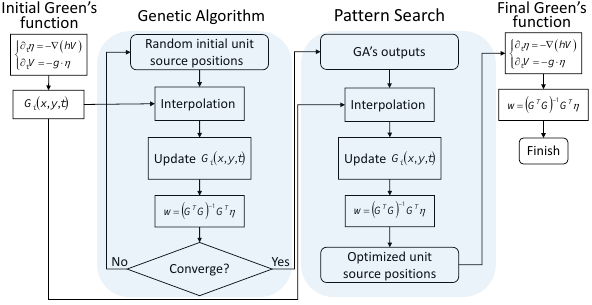
Figure 5. Flowchart of model development